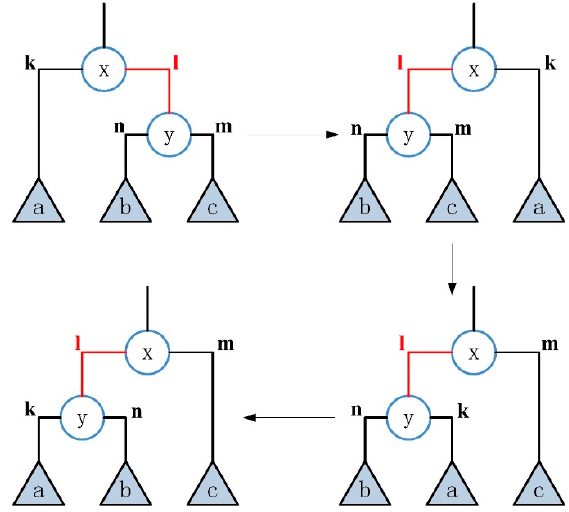
Figure 5. The 𝛼 transformation of the inner edge of type